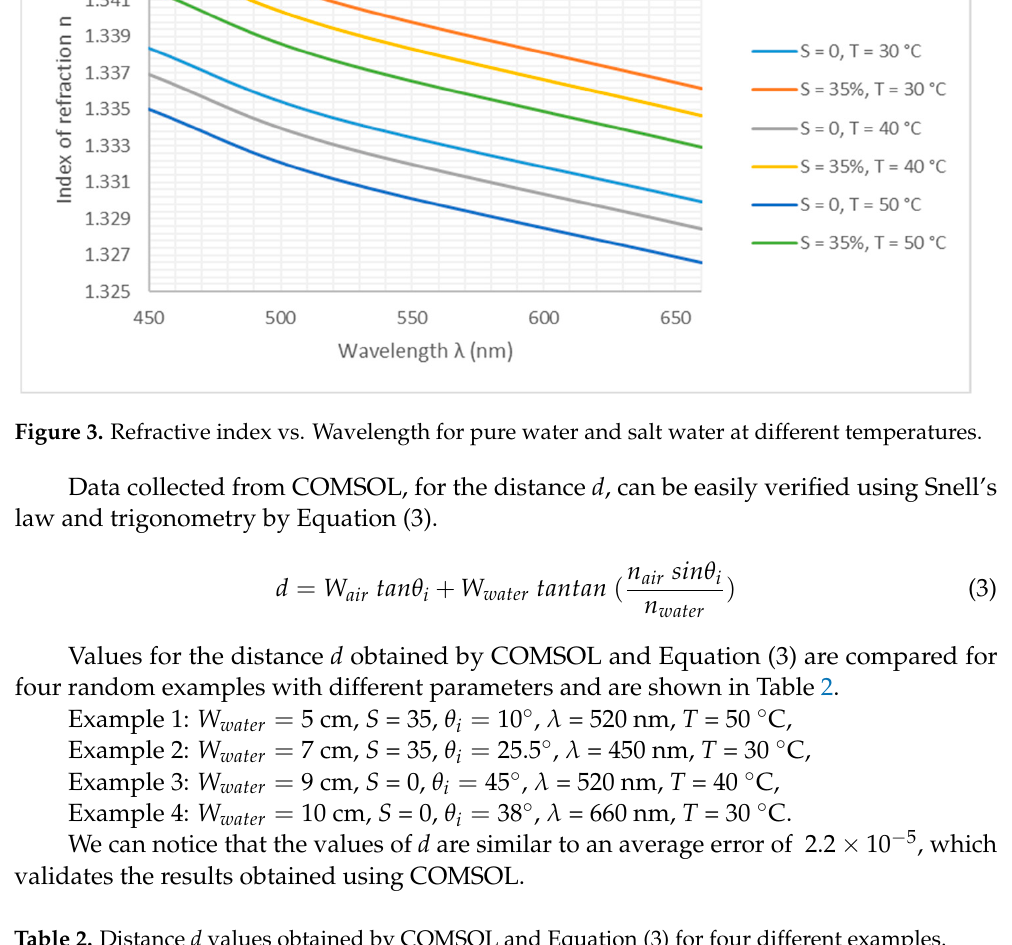
Table 2. Distance d values obtained by COMSOL and Equation (3) for four different examples.